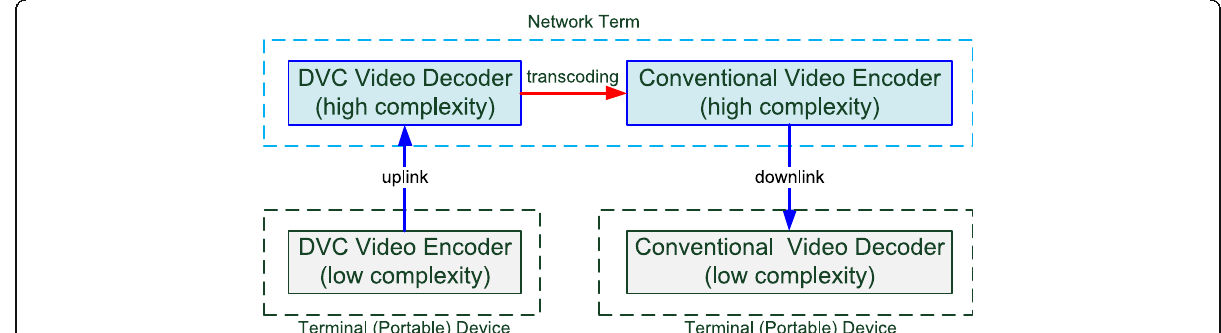
Fig. 1 DVC network scenario with low-complexity encoding and decoding